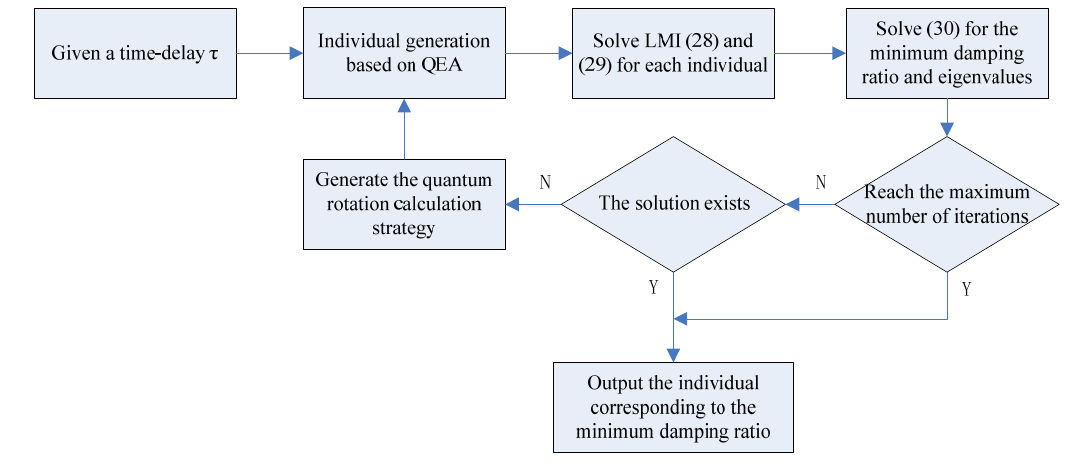
Figure 7. Flow chart of the controller design algorithm.